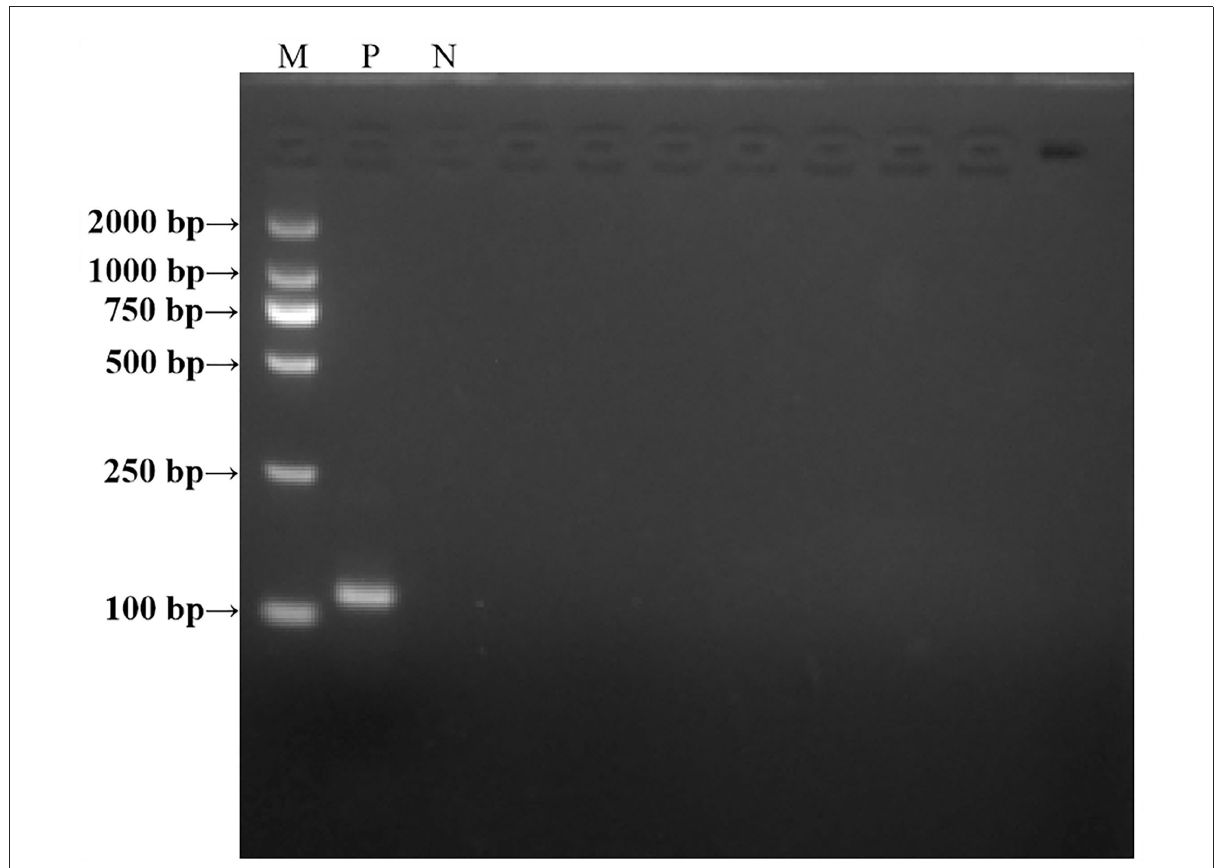
FIGURE2 Agarose electrophoresis PCR-amplified products verified the results of the RT-RAA primer size. M, D 2000 Marker; P, positive control, that is, ALV nucleic acid; N, negative control, that is, ddH 2